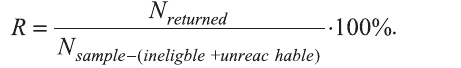
Table 3. Spearman’s rho correlation between variables associated with product value